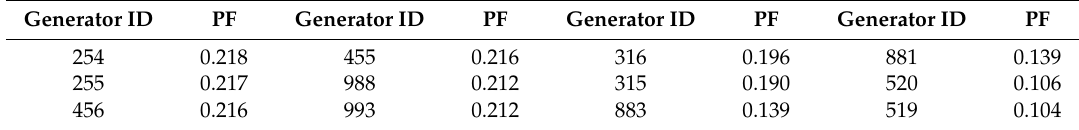
Table 4. Generator PF analysis